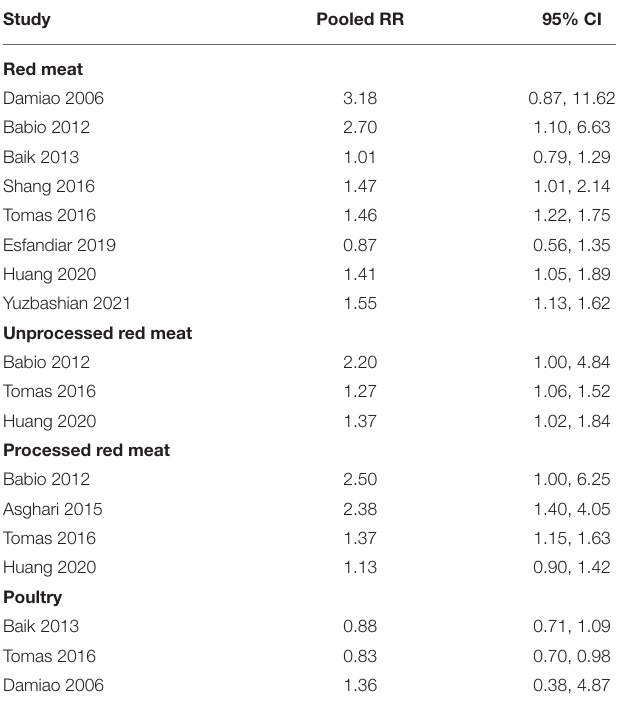
TABLE 3 | Summarized RR of MetS for highest vs. lowest category of